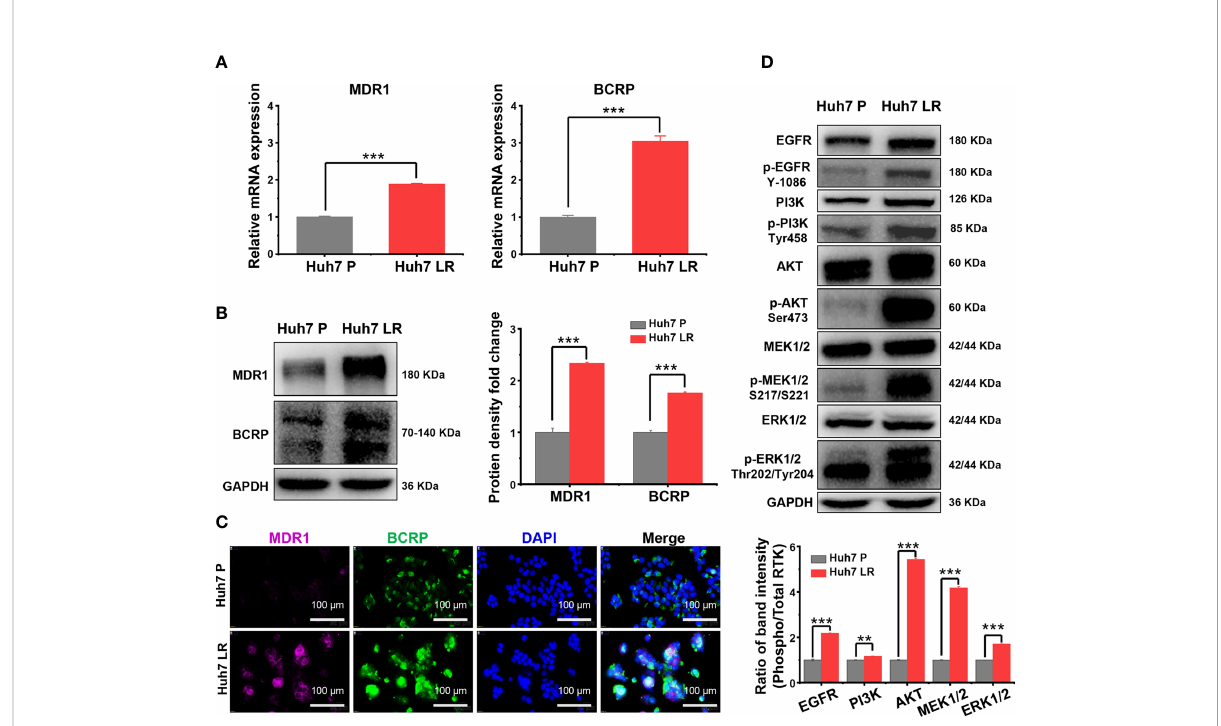
FIGURE 3 MDR1 and BCRP overexpression and EGFR signalling pathway activation following LR induction. (A – C) qRT-PCR, western blotting, and immuno fl uorescence analysis demonstrated that MDR1 and BCRP expression was upregulated following LR induction. Scale bars, 100 m m. (D) Western blotting revealed that EGFR and its downstream MEK/ERK and PI3K/AKT pathways were markedly activated following LR induction. ** p < 0.01. *** p <